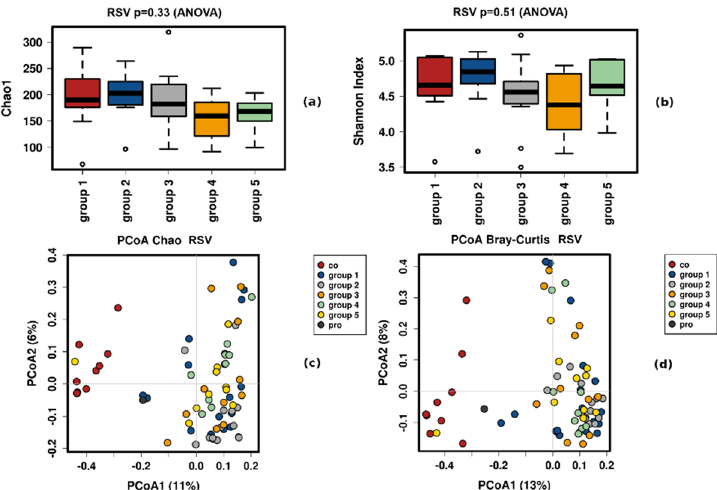
Figure 5. Redundancy analysis (RDA) plot of female and male participants. “No” (grey) indicates the controls. The figure shows significant differences between the sexes. Female, male, and controls are clustering separately. The overlapping of controls with a female sample indicates a low number of reads in the female sample.